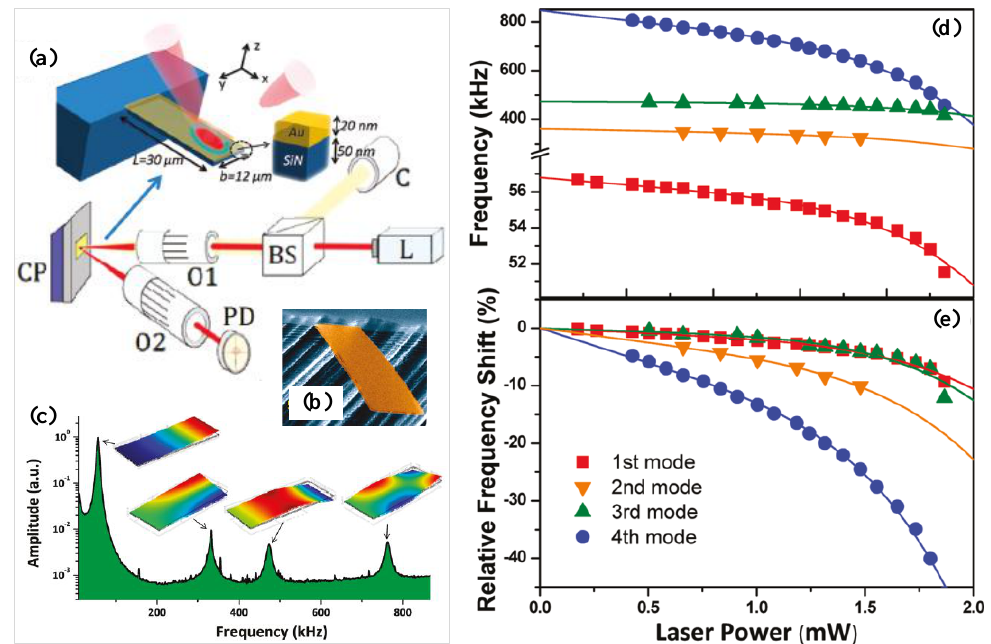
Figure 26. Laser-induced resonant frequency shift reported by Pini et al . [319]. ( a ) Schematic diagram of the structure and dimensions of the laser beam deflection technique; ( b ) SEM of the fabricated bimetallic cantilever; ( c ) Frequency spectrum of